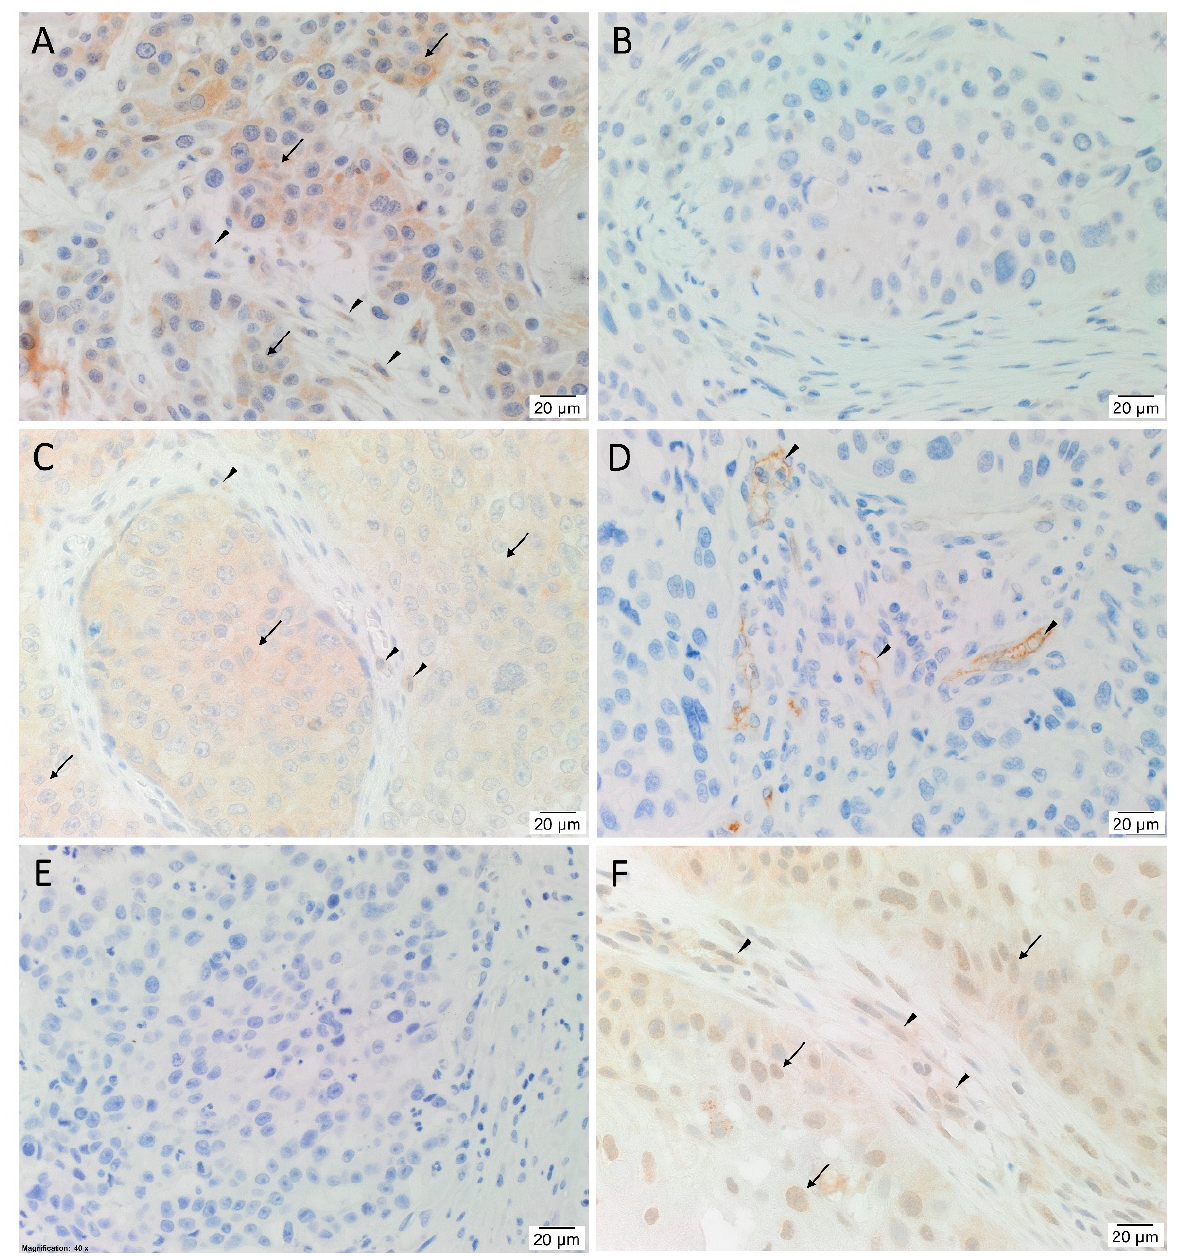
Figure 1. Representative immunohistochemical-stained-sections of metastatic head and neck cutaneous squamous cell carcinoma tissue samples stained for components of the renin-angiotensin system. Angiotensinogen ( A , brown) was expressed on cells within the tumor nests (TNs, arrows ), and to a lesser degree in the peri-tumoral stroma (PTS, arrowheads ). Renin ( B , brown) was not present in the tissue samples. PRR ( C , brown), demonstrated cytoplasmic expression of cells within the TNs ( arrows ), and to a lesser extent cells within the PTS ( arrowheads ) in two cases. ACE ( D , brown) was expressed on the endothelium of the tumor microvessels within the PTS ( arrowheads ). ACE2 ( E , brown) was not present in the tissue samples. AT 2 R ( F , brown) was expressed by cells within the TNs ( arrows ) and the PTS ( arrowheads ). Nuclei were counter-stained with hematoxylin ( A – F , blue). Original magnification: 400×. n = 20.